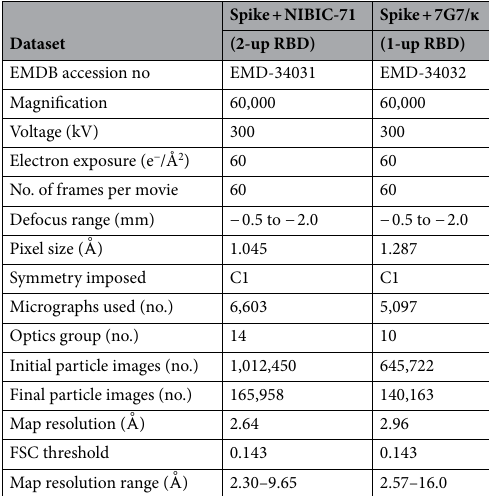
Figure 3. Neutralization mechanisms of NIBIC-71 and 7G7. ( A ) Truncated S proteins tagged with Flag and 6 × His were synthesized with the Bac-to-Bac baculovirus system. Purified proteins were dialyzed with PBS. ( B ) The binding regions of these mAbs were determined using ELISA with the recombinant proteins shown in A as antigens. The vertical axis shows normalized values (arbitrary unit) relative to absorbance obtained with ELISA against His. ( C ) and ( D ) Cryo-EM sharpened maps of the homotrimeric S protein complexed with NIBIC-71 ( C ) or 7G7/κ ( D ). The atomic model of S protein and the homology models of the Fabs are manually fitted into the maps. The regions corresponding to the two mAbs are shown in blue, green, and red. The heavy and light chains are shown in different colors. The NTD and RBD region in the S protein are shown in purple and yellow, respectively. One of S2’ and S1/S2 cleavage site are shown in red and blue circle, respectively. ( E ) The neutralizing activity of these mAbs was assessed with a luciferase assay in triplicate. VeroE6-TMRPSS2 cells were infected with WT SARS-CoV-2 introduced by nanoLuciferase. The cells were pre-incubated with or without serially diluted recombinant mAbs from 10 to 0.001 µg/mL. Bioluminescence was measured using a luminometer. ( F ) The inhibitory effect of S protein–ACE2 binding was evaluated with ELISA in triplicate. ( G ) The inhibitory effect of S1/S2 cleavage was evaluated with ELISA. In E–G, inhibition efficiency (%) was calculated relative to values derived from the negative control samples without any mAbs. ECD, extracellular domain; S1, subunit 1; S2, subunit 2; NTD, N-terminal domain; RBD, receptor binding domain; SD, subdomain.